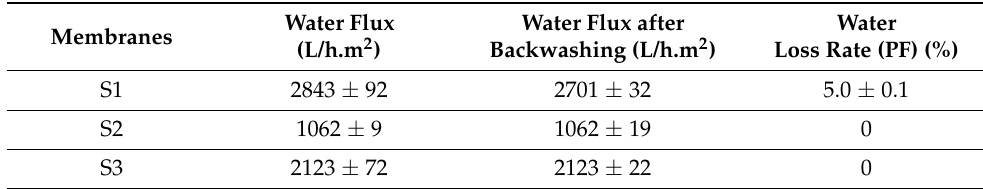
Table 5. Water flux densities measured before filtration of the bacteria and after the backwashes with